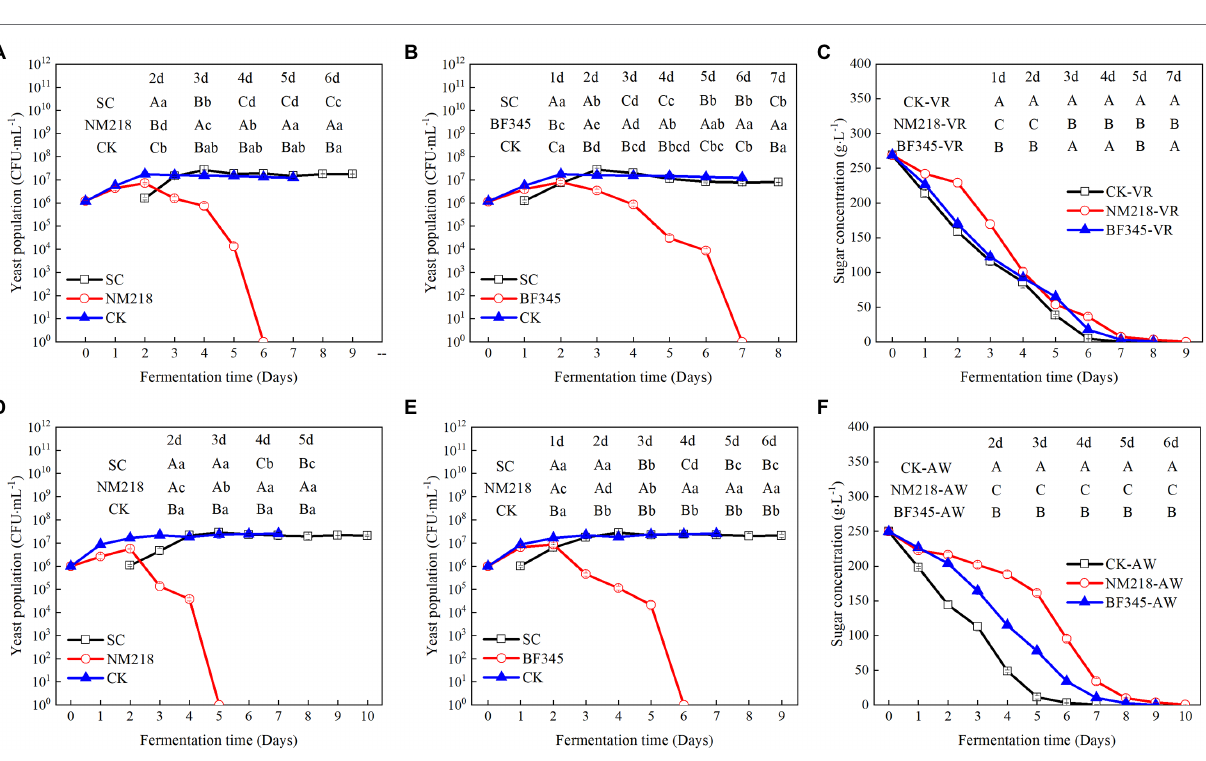
FIGURE 3 | Yeast population dynamics and sugar concentration during sequential fermentations in Cabernet Sauvignon and Chardonnay must. (A,B) yeast population dynamics during Cabernet Sauvignon must fermentation and (D,E) yeast population dynamics during for Chardonnay must fermentation. (C) change in the sugar content during Cabernet Sauvignon must fermentation. (F) change in the sugar content during Chardonnay must fermentation. CK represents strains S. cerevisiae (control). NM218 and BF345 represent strains M. guilliermondii NM218 and H. uvarum BF345, respectively. SC represents the strains S. cerevisiae in sequential inoculation. CK-VR; pure culture of S. cerevisiae (VR) used as a control in Cabernet Sauvignon wines. NM218-VR; sequential inoculation of M. guilliermondii NM218 and VR at 48 h in Cabernet Sauvignon wines. BF345-VR; sequential inoculation of H. uvarum BF345 and VR at 24 h in Cabernet Sauvignon wines. CK-AW; pure culture of S. cerevisiae (AW) used as a control in Chardonnay wines. NM218-AW; sequential inoculation of M. guilliermondii NM218 and AW at 48 h in Chardonnay wines. BF345-AW; sequential inoculation of H. uvarum BF345 and AW at 24 h in Chardonnay wines. Different letters (a,b,c,d,e) in the same row for each fermentation time indicate significant differences (Duncan tests; p < 0.05). Different letters (A,B,C) in the same column for different yeast populations indicate significant differences (Duncan tests; p <